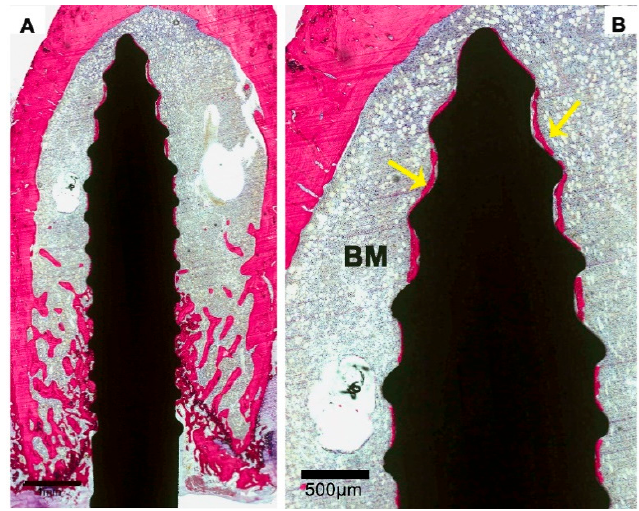
Figure 6. Low- and high-magnification images of a specimen of the ZOL-Pre+Post group. ( A ) Low-magnification image showing that bone formation mainly occurred at the crestal side of the implant and extended about halfway up the implant length. ( B ) High magnification revealed that a thin layer of bone covered the implant surface (yellow arrows).